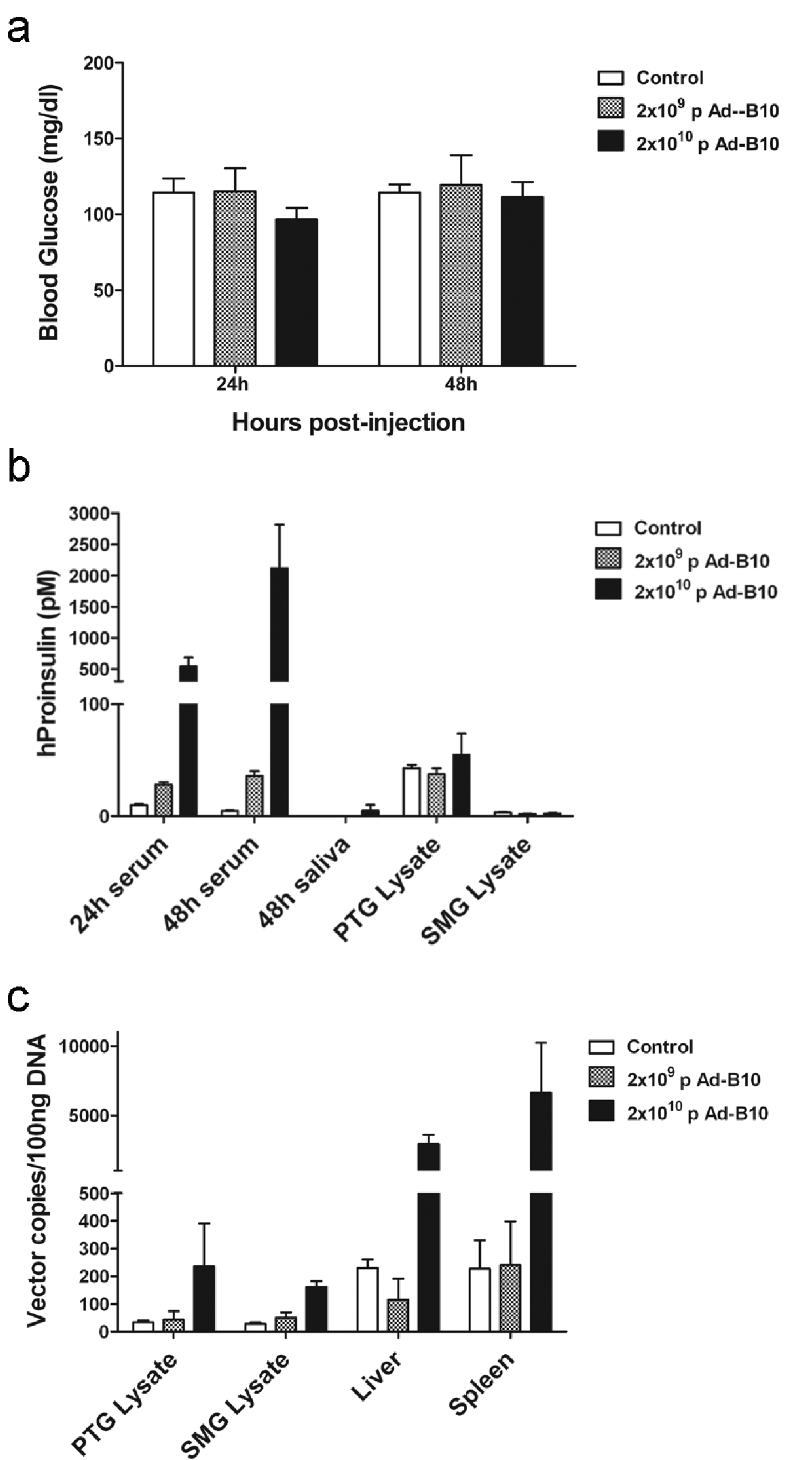
Figure 3. Dose dependent secretion of hProinsulin in non-diabetic mice transduced with rAd-proinsulin-B10 via I.V. injection. rAd- proinsulin-B10 particles or saline (Control) was delivered by I.V. injection. Serum samples were obtained at 24 h and 48 h post-transduction and saliva, parotid gland (PTG), submandibular gland (SMG), liver and spleen tissues were collected at the conclusion of the experiment (48 h). ( a ) Blood glucose (mg/dl) measurements at 24 h and 48 h post-transduction. No statistical difference in glucose levels was observed between groups (ANOVA) ( b ) Sera, saliva and protein lysates from PTG and SMG were assayed for hProinsulin (pM) by ELISA. ( c ) QPCR analysis of rAd vector genome tissue distribution at the conclusion of the experiment. Data are expressed as rAd genome copies detected in 100 ng of tissue genomic DNA. For all panels, bars indicate mean + SEM of n=3 mice per group.